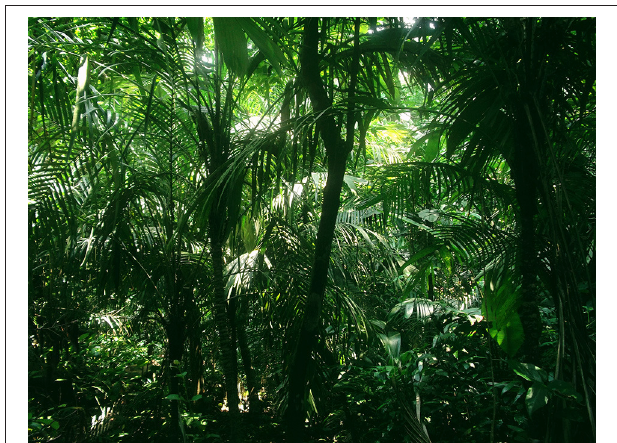
FIGURE 1 | In the Anthropocene, human impacts on tropical forests are threatening biodiversity, even inside reserves. In the Los Tuxtlas Station, SE Mexico, fragmentation and defaunation have conduced to the exponential growth of an understory palm with negative consequences for biodiversity conservation and ecosystem functioning. Image courtesy of Iván A.